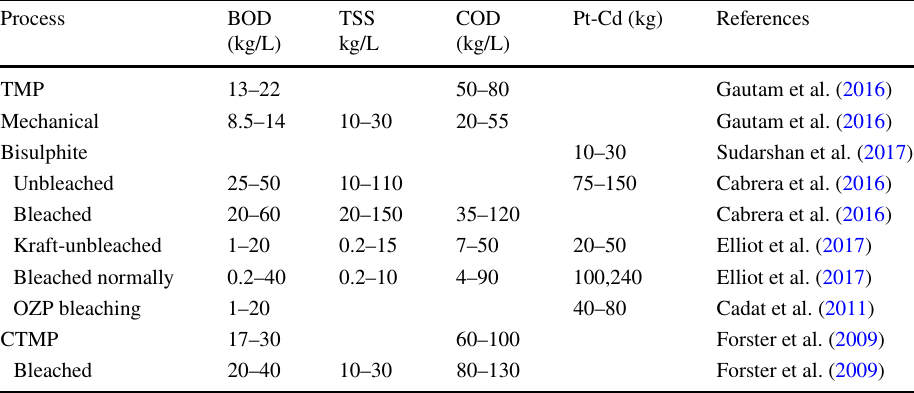
Table 6 Composition of effluent from paper and pulp industry (Data provided in this table has been